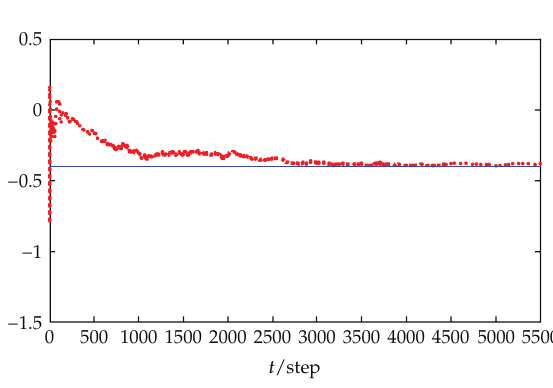
Figure 1: ρ 1 and the convergence of estimation value (cid:11) ρ 1 (cid:5) t (cid:6) .